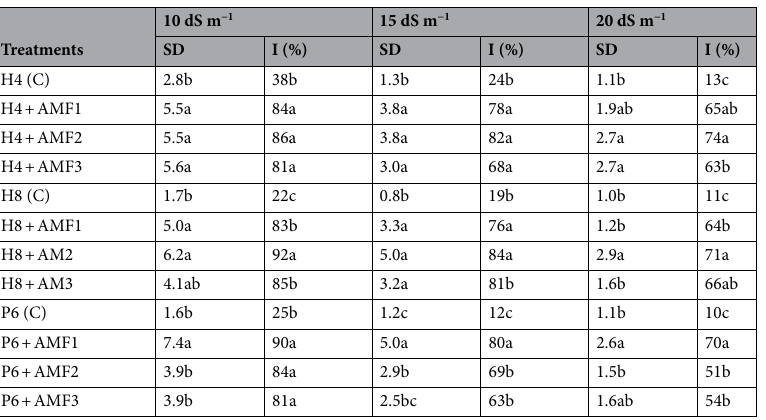
Table 2. Effect of salinity on AMF spore density (spore number g −1 dry soil; SD) and intensity of root colonization (I) of three eucalyptus clones (H4, H8, P6) pre-inoculated with various species of AMF after 90 days of cultivation at three salinity levels. AMF1; Glomus sp.2, AMF2; G. albida , AMF3; G. decipiens , and control (C); without pre-inoculation. Values followed by different letters, per salinity level and clone, are significantly different ( P ≤ 0.05) by